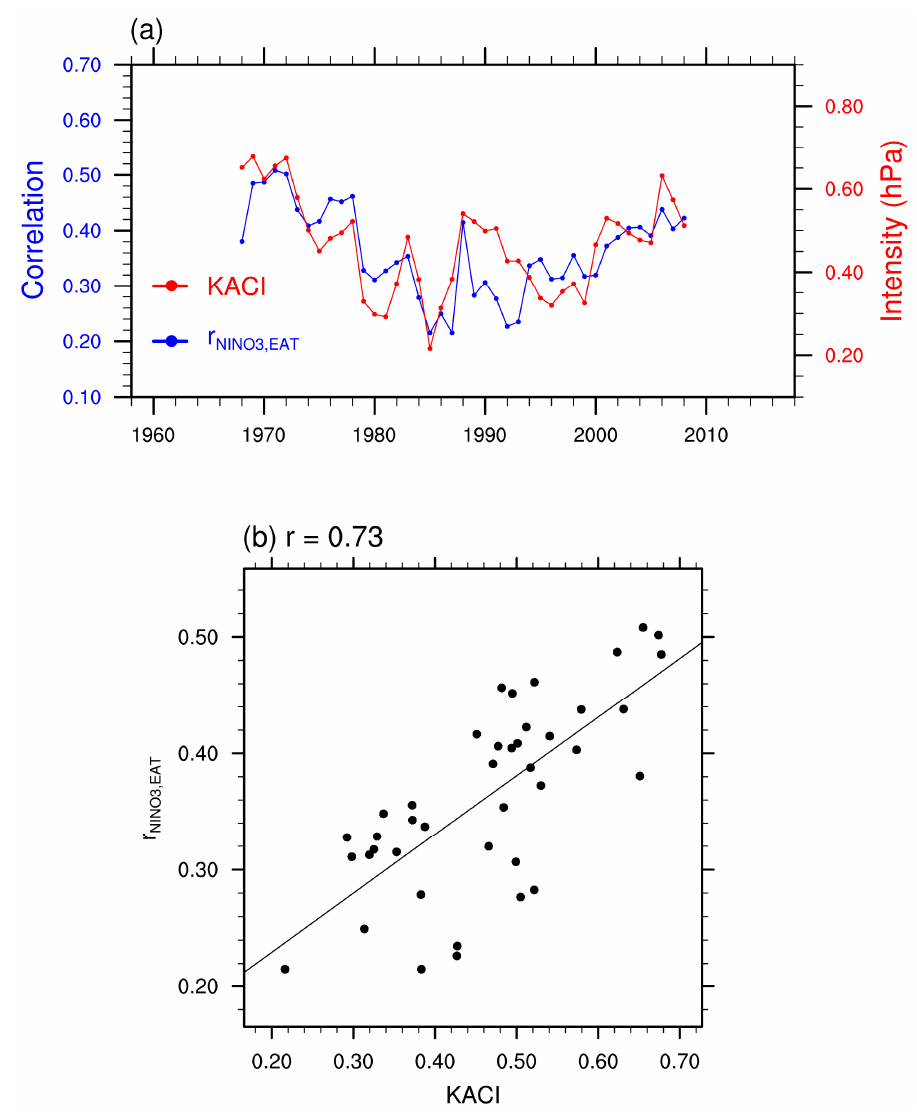
Figure 4. ( a ) Sliding correlation coefficient between the wintertime Niño-3 and EAT indices, i.e., r NINO3,EAT , with a 21 year window (blue line, using left y -axis), and the sliding Kuroshio anticyclone index (KACI, 30°–50°N, 135°–165°E) in a 21 year sliding window (red line, using right y -axis). ( b ) Scatter plot of sliding KACI ( x -axis) versus sliding r NINO3,EAT ( y -axis).